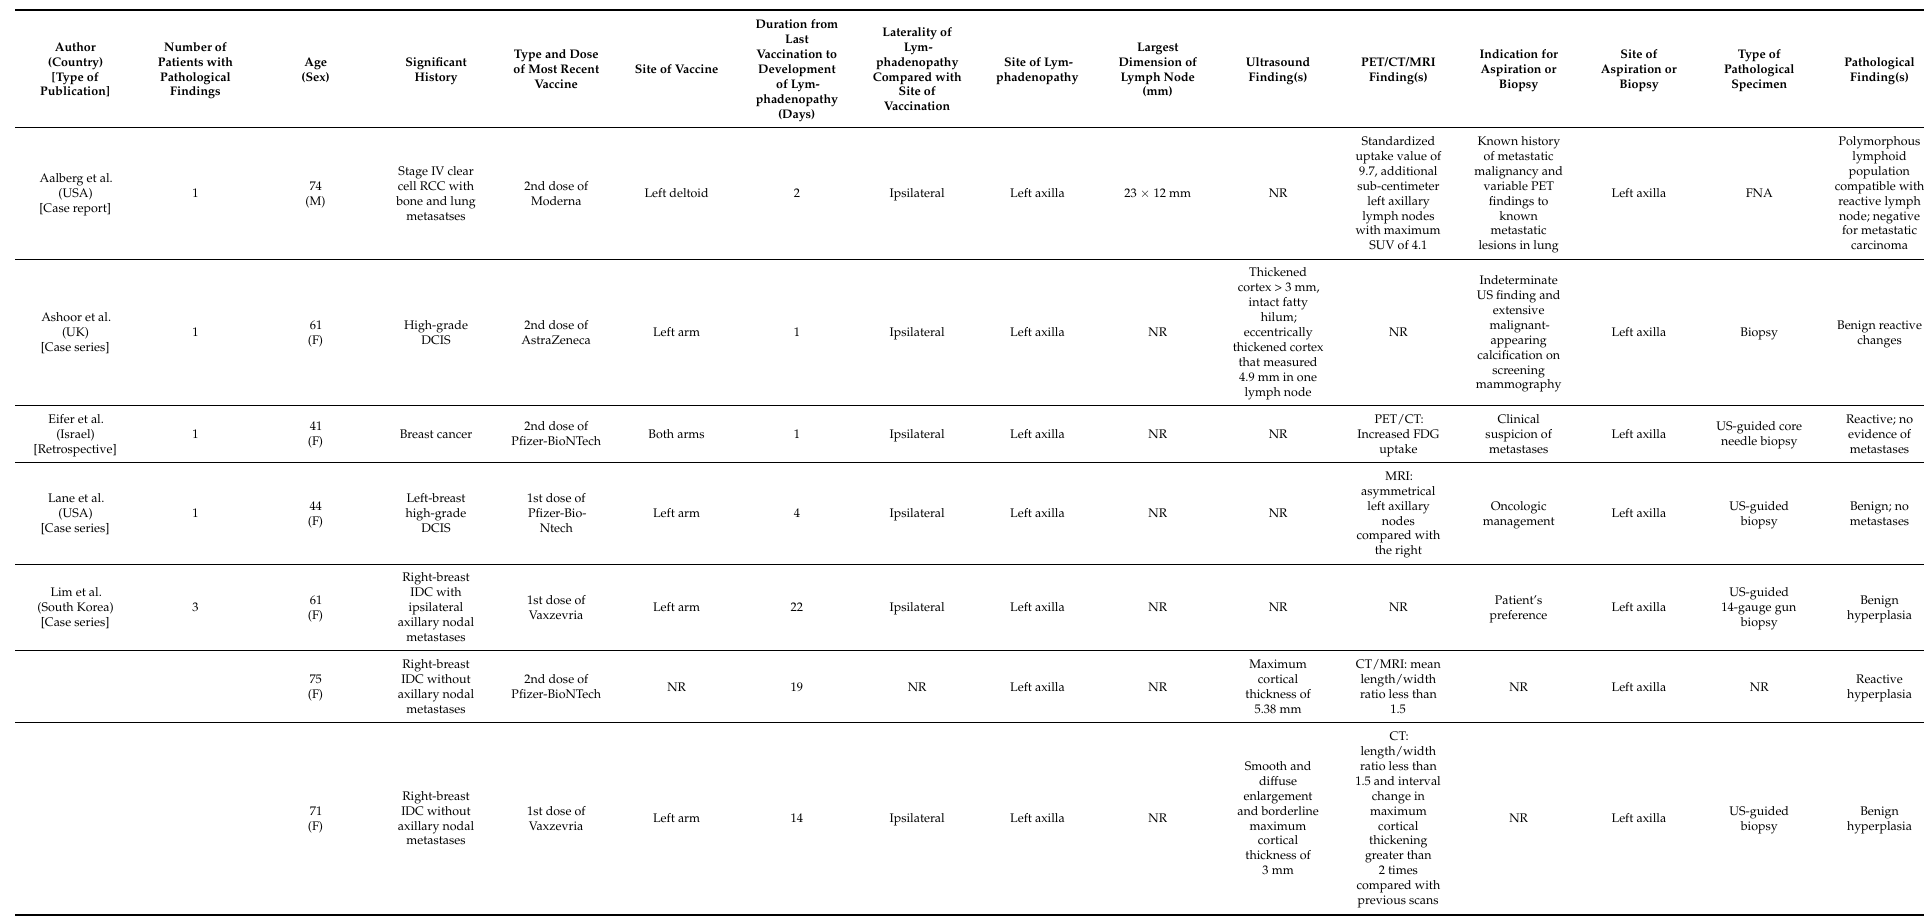
Table 3. Findings of subclinical lymphadenopathy detected on imaging (SLDI) studies. NR, not reported; F, female; M, male; US, ultrasound; PET/CT,